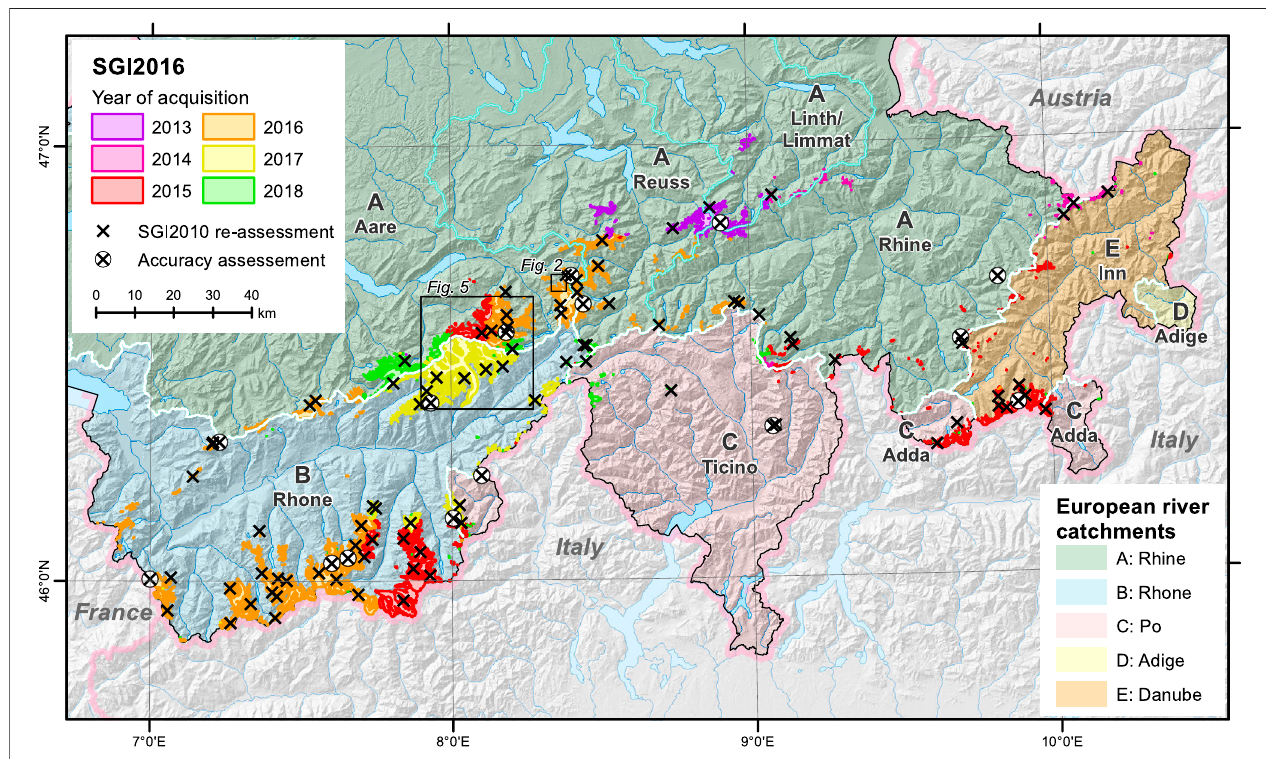
FIGURE 1 | Overview of glacierization and main hydrological catchments in Switzerland. The Swiss contribution to the fi ve major European streams Rhine ( A , green), Rhone ( B , blue), Po ( C , red), Adige ( D , yellow) and Danube ( E , orange) is illustrated. The catchment borders are marked with a white line. The glacierization is illustrated by the new SGI2016 (this study), and colors refer to the year of acquisition of the aerial image used for glacier mapping. The sample of 100 glaciers used for a re-assessment of the SGI2010 (crosses) and the 15 glaciers used for the accuracy assessment (circled crosses) are indicated. The small rectangles show the extents enlarged in Figures 2 , 5